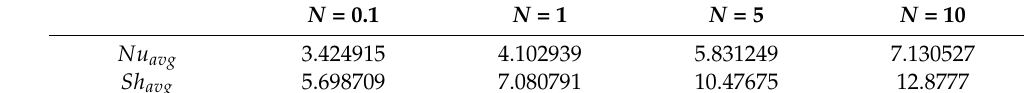
Table 6. Average Nu and Sh comparison.